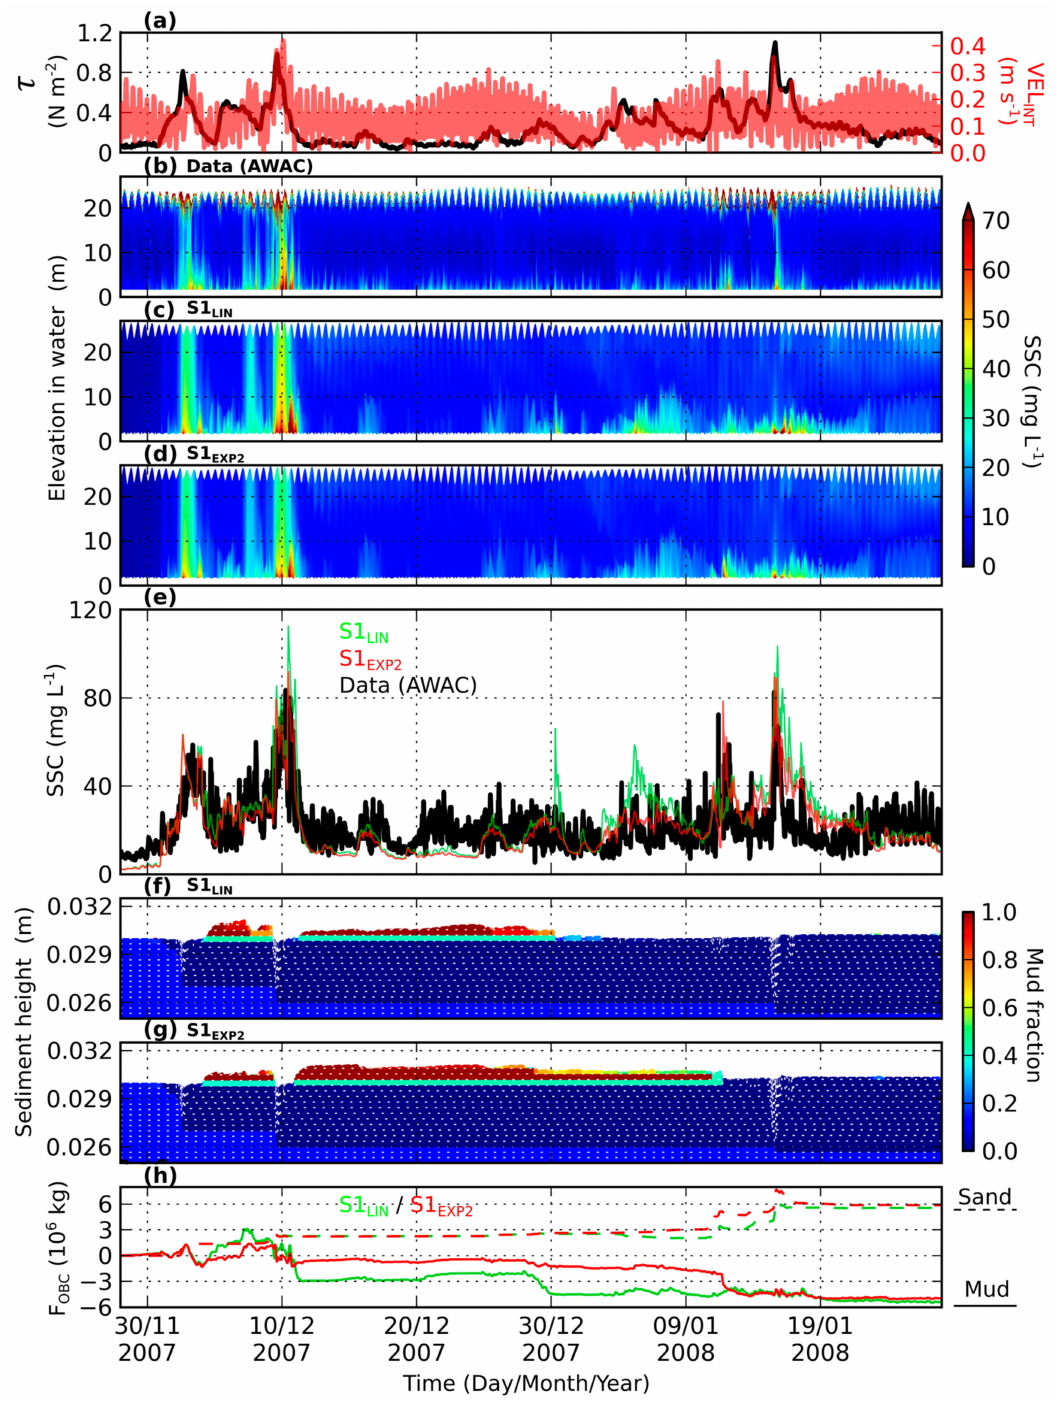
Figure 7. Comparisons of the results of the 3D model obtained from erosion settings S1 LIN and S1 EXP 2 , and measurements made by the AWAC acoustic profiler. ( a ) Shear stresses τ and depth-integrated currents VEL INT ; ( b ) measured SSC over the entire water column; ( c , d ) computed SSC for S1 LIN and S1 EXP 2 simulations; ( e ) time series of measured and modelled SSC variations at the level of the AWAC first cell (1.67 m above the bottom); ( f , g ) changes in the seabed (mud fraction, thickness of the sediment layers) in the two simulations (white dotted lines represent the boundaries of the sediment layers); and ( h ) integrated amount of SSC advected through the water column (solid lines represent mud and dotted lines represent